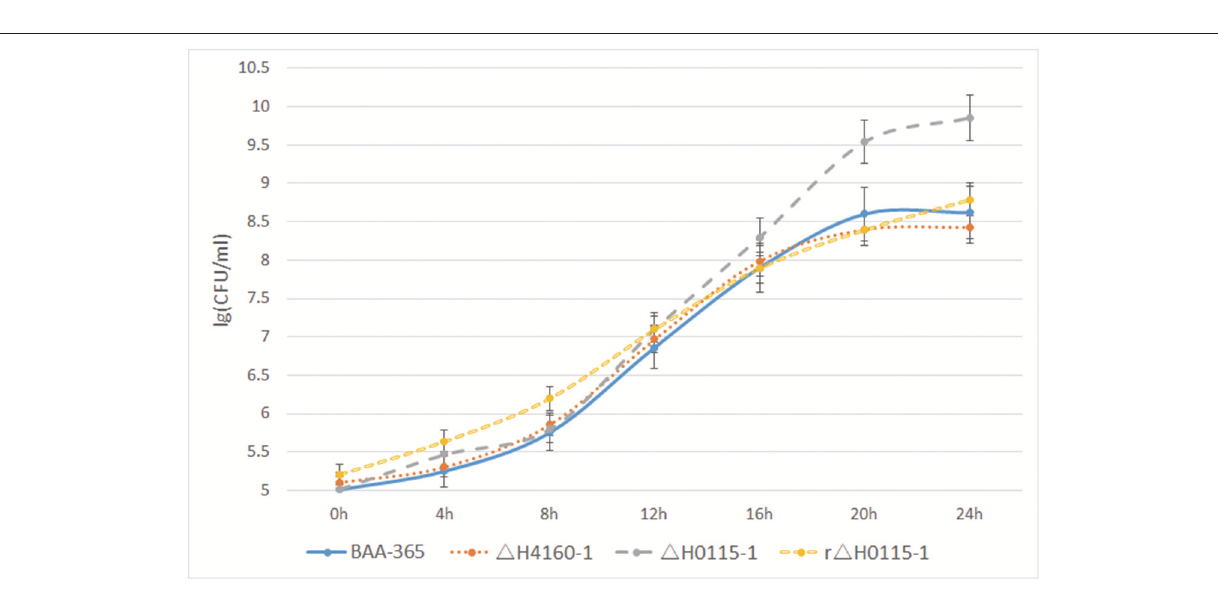
Frontiers in Microbiology |